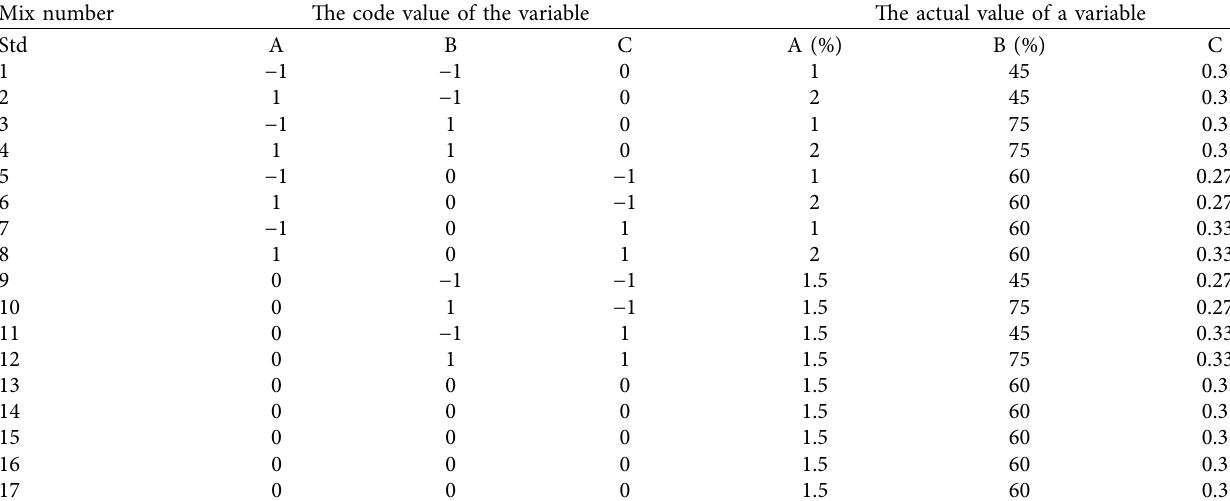
Table 4: The mixing ratio of the 17 experimental